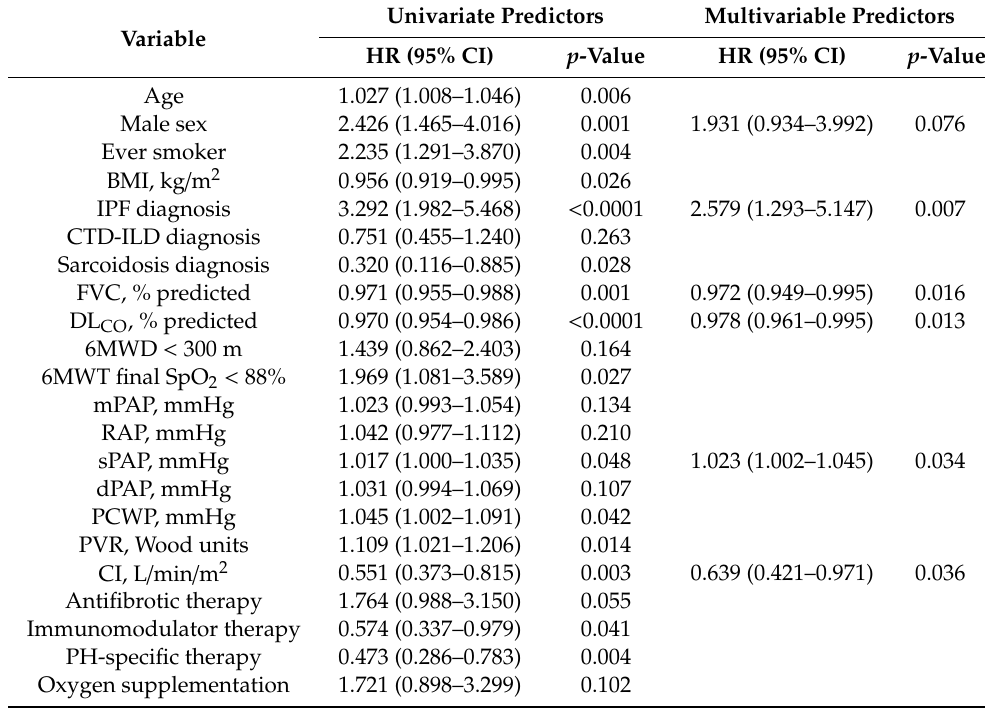
Table 4. Cox proportional hazards regression analysis showing predictors of mortality in patients with pulmonary hypertension ( n = 152).